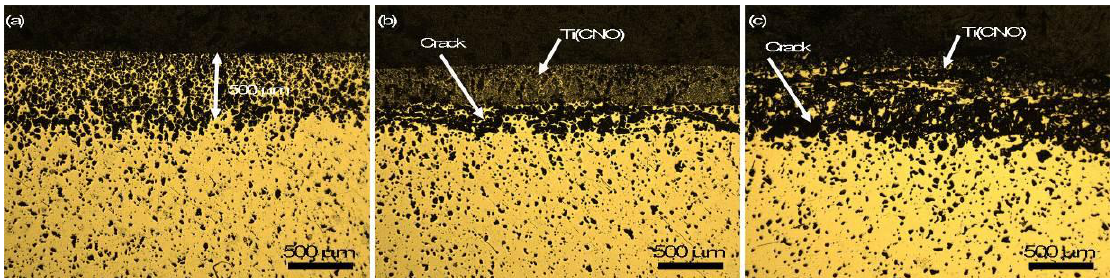
Figure 3. Micrographs of the cross-sections of sintered small compacts at different sintering temperatures: ( a ) 1100 °C; ( b ) 1250 °C; and ( c ) 1400 °C. All compacts were sintered for 4 h at the respective temperature.